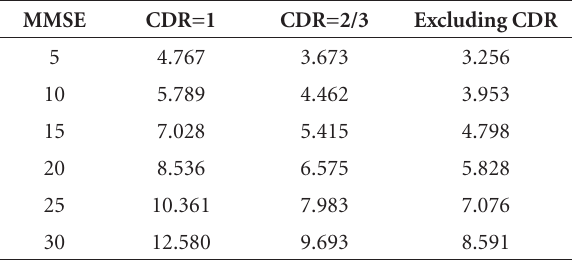
Table 3. Number of answers and MMSE.